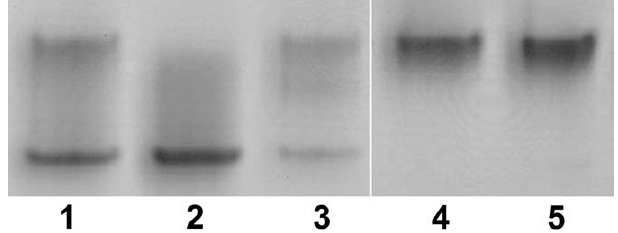
Figure 6. Nondenaturing PAGE Conformation Study of Recombinant Human TG2 TG2 was incubated with effectors, then subjected to electrophoresis. Lane 1: TG2 incubated without effectors. As purified, this sample assumes two conformational states. Extended dialysis of purified TG2 leads to virtual disappearance of the faster-migrating species, suggesting that in the absence of both GTP and calcium, the protein adopts an open-like conformation. Lane 2: incubation of TG2 with GTP and MgCl 2 , allosteric inhibitors of the enzyme, increases the relative abundance of the conformation with higher electrophoretic mobility. Lane 3: incubation of TG2 with CaCl 2 , the enzyme activator, reduces the relative abundance of the higher mobility conformer. The lower overall intensity of this lane can be explained by oligomerization, as evidenced by multiple bands of lower electrophoretic mobility (unpublished data). Lane 4: active-site–inhibited TG2 incubated without effectors assumes a conformation with the lower electrophoretic mobility. Lane 5: incubation of active-site–inhibited TG2 with GTP and MgCl 2 does not cause a shift in mobility as it does for uninhibited